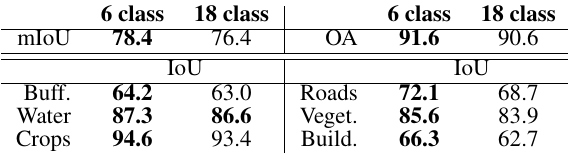
Table 3. Results (in %) for simple and transposed to 6 class complex nomenclature with SPOT